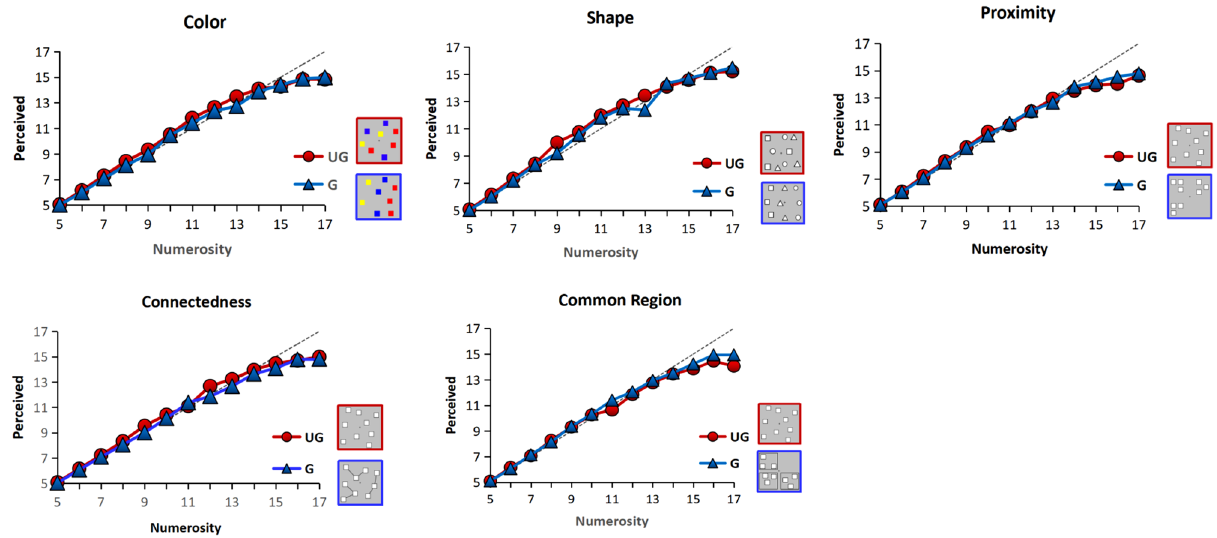
Figure 5. Perceived numerosity. Average perceived numerosity for all grouping cues and tasks, averaged across